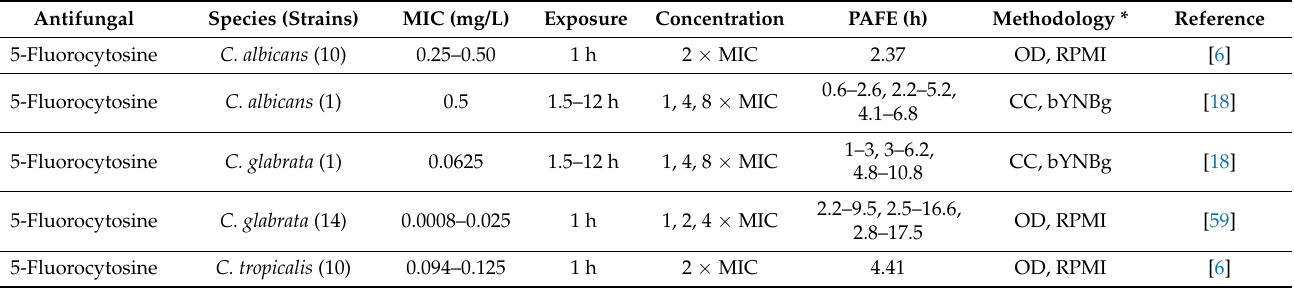
Table 4. PAFE in vitro of